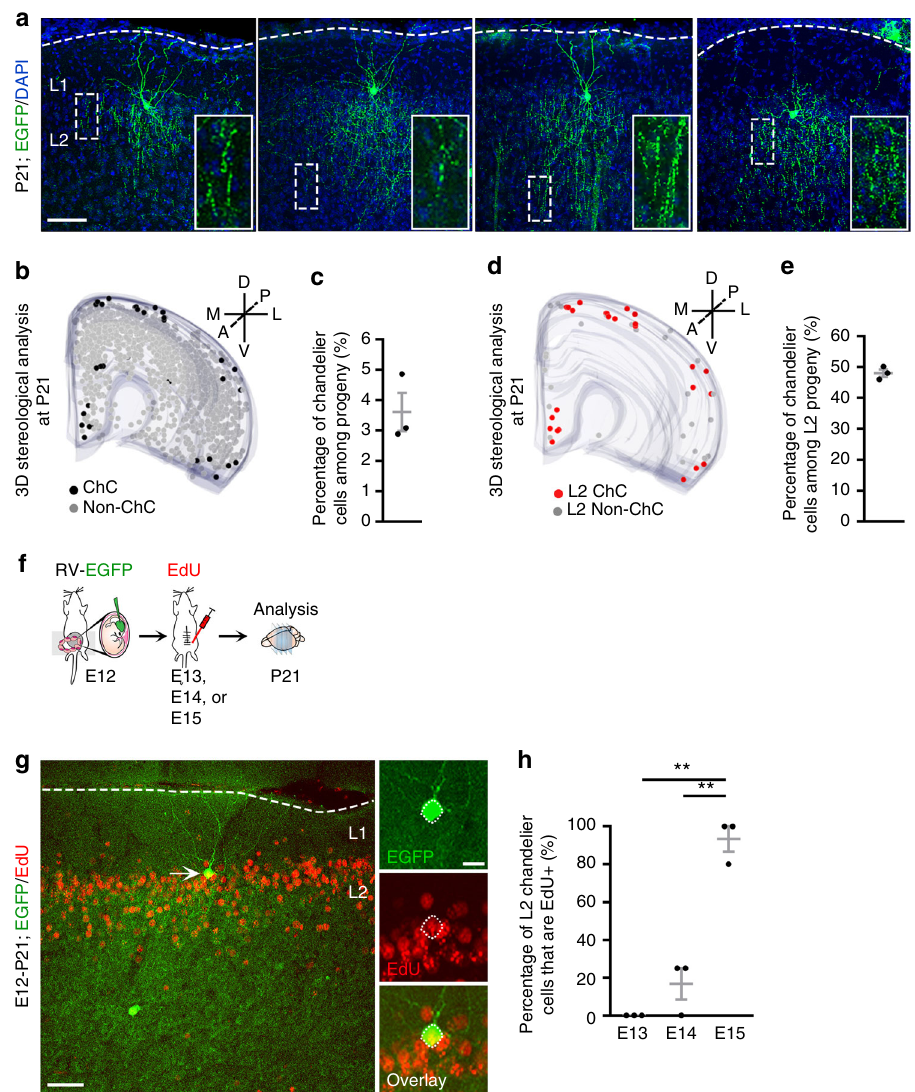
Fig. 3 Dividing NKX2.1 + MGE/PoA RGPs at E12 generate super fi cial layer chandelier cells at the late embryonic stage. a Images of P21 neocortices injected with EGFP-expressing retrovirus at E12, stained for EGFP (green), and counterstained with DAPI (blue). EGFP-expressing chandelier cells were frequently found at the border of super fi cial layers 1 and 2. High magni fi cation images of the vertical arrays of axonal cartridges characteristic of the chandelier cell (broken rectangles) are shown in the insets. Broken lines indicate the pial surface. Scale bar: 50 µ m. b 3D reconstruction image of a neocortical hemisphere showing EGFP-expressing chandelier cells and non-chandelier cells. Black and gray dots represent the cell bodies of EGFP-expressing chandelier and non- chandelier cells, respectively. D dorsal, P posterior, L lateral. c Percentage of chandelier cells among EGFP-expressing neocortical interneurons. Gray lines represent mean ± SEM. Black dots represent individual brains ( n = 3). d 3D reconstruction image of a neocortical hemisphere showing EGFP-expressing chandelier and non-chandelier cells in layer 2 only. Red and gray dots represent the cell bodies of EGFP-expressing chandelier and non-chandelier cells, respectively. e Percentage of chandelier cells among EGFP-expressing interneurons in L2. Gray lines indicate mean ± SEM. Black dots represent individual brains ( n = 3). f Schematic of the experimental design for birth dating analysis of EGFP-expressing chandelier cells. Animals received in utero retrovirus injection at E12 and EdU at E13, or E14, or E15 were analyzed at P21. g Image of P21 neocortex injected with EGFP-expressing retrovirus at E12 followed by EdU injection at E15, stained for EGFP (green) and EdU (red). The arrow indicates an EGFP-expressing chandelier cell labeled by EdU injection at E15. High magni fi cation images of the chandelier cell are shown to the right. The broken line indicates the pial surface. Scale bars: 150 μ m and 10 µ m. h Percentage of EGFP-expressing chandelier cells that are labeled by EdU. Gray lines represent mean ± SEM. Black dots represent individual brains ( n = 3 per time point). ** P = 0.005 (E13-E15); ** P = 0.002 (E14-E15) (unpaired t -test with Welch ’ s correction)